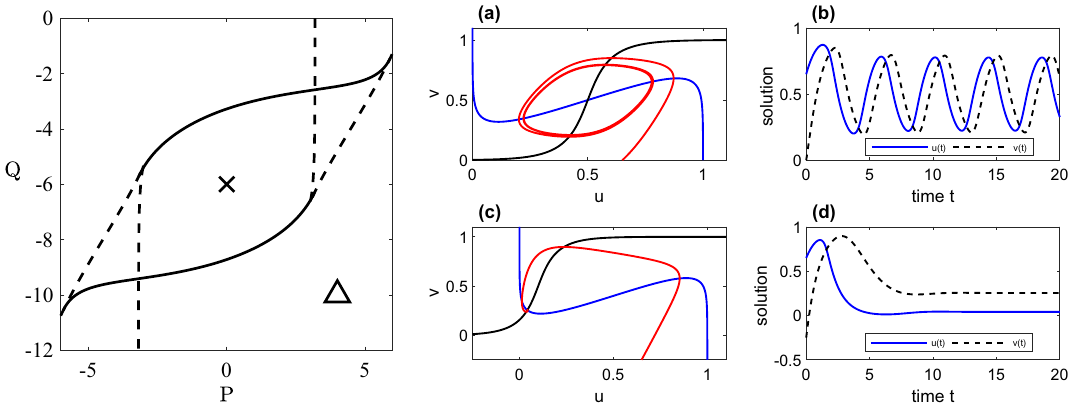
Figure 2. Bifurcation sets and numerical simulations for a single Wilson–Cowan node (12), (13) with c 1 = c 2 = c 3 = 10 and c 4 = − 2 . LHS: The dashed curve denotes the saddle-node bifurcation set and the solid curve the Hopf bifurcation set. RHS: ( a , b ) and ( c , d ) display phase plane and time courses for oscillatory and steady state solutions (for parameter values indicated by the cross and triangle in the left-hand panel) of Eqs. (12), (13) with ǫ = 0